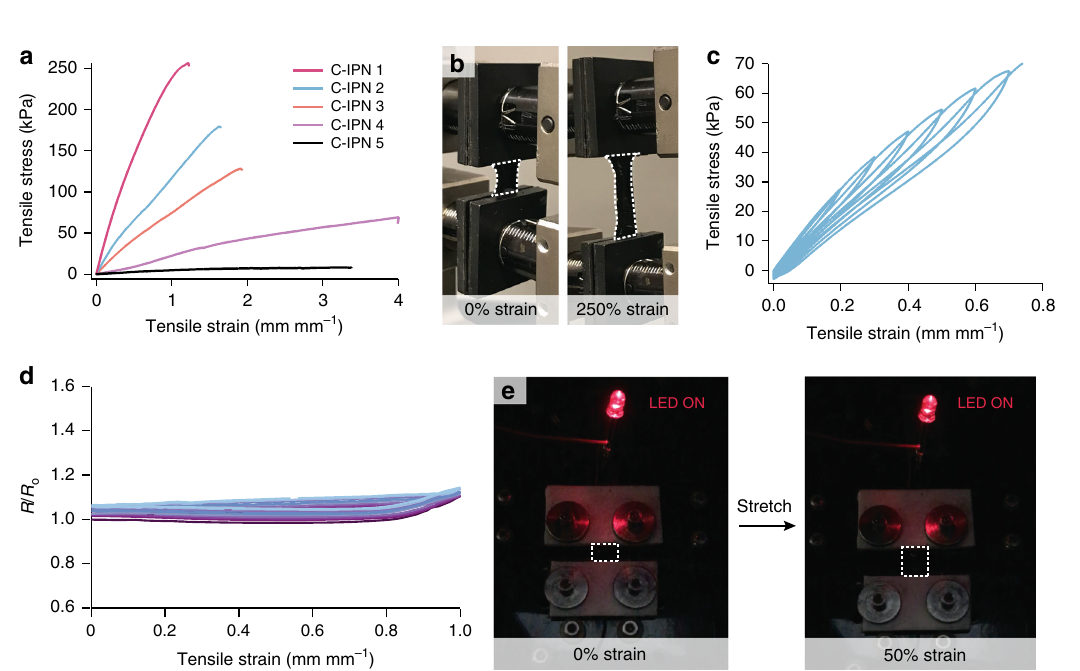
Fig. 3 Mechanical and strain-dependent properties of C-IPN hydrogels. a Tensile elongation curves of different C-IPN formulations, showing that all formulations can be stretched to over 100% despite large differences in the elastic moduli, which is given by the initial slope of the stress/strain curve. b Picture of a C-IPN 4 gel being stretched to 250%. c Cyclic stress/strain tensile data for C-IPN 2 exhibiting minimal hysteresis, re fl ecting its excellent elastic properties. d Change in resistance, expressed as a ratio between resistance ( R ) and initial resistance ( R o ), across a C-IPN 2 gel as it is cycled reversibly between 0 and 100% strain for 10 cycles. Despite the large changes in tensile strain, the resistance stays fairly constant near its initial value. e Due to the largely strain independent conductivity of the gels, it is able to keep an LED lit even after being stretched to 50%